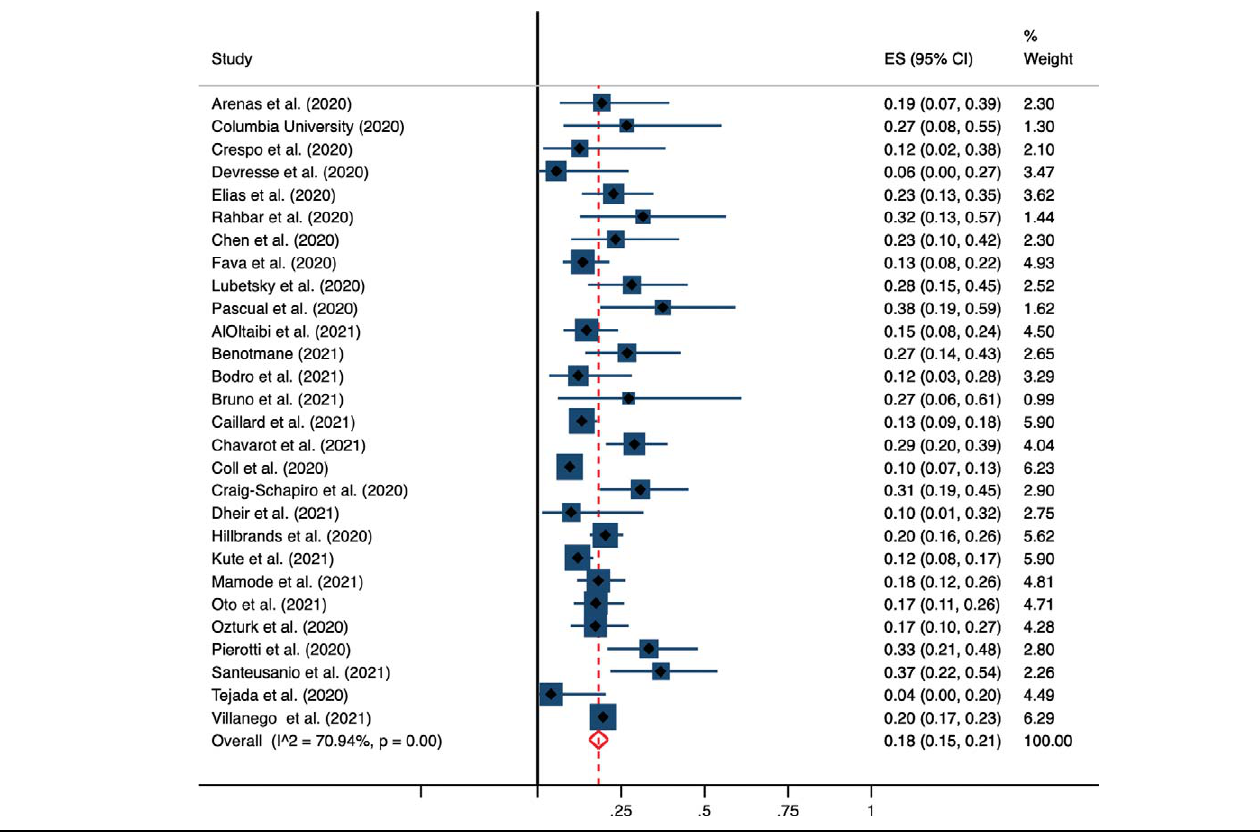
Figure 3. Pooled estimate on mechanical ventilation rate of kidney transplant recipients with COVID-19